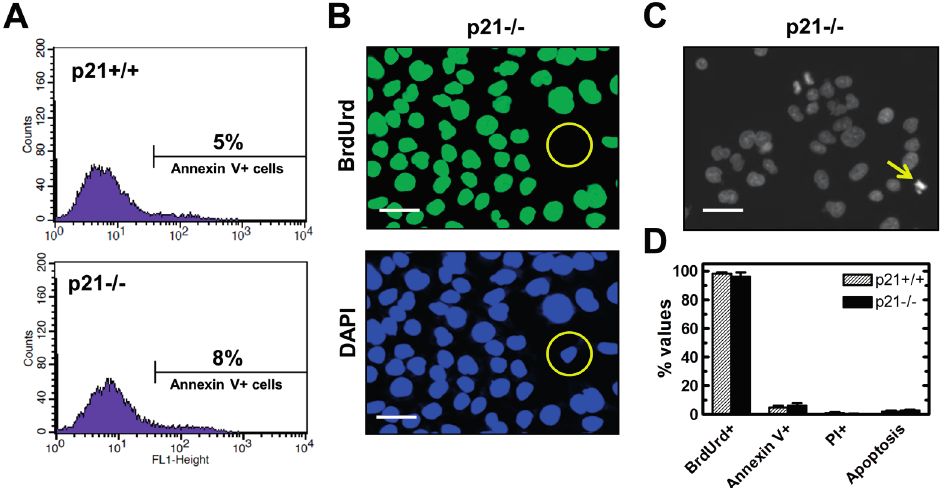
Figure 4. Comparison of HCT116p21+/+ and HCT116p21 − / − cultures for apoptosis, viability and proliferation. ( A ) Flow cytometric evaluation of Annexin V-positive (apoptotic) cells; ( B ) Evaluation of replicating cells by the BrdUrd immunofluorescence assay. Circles mark a cell that did not exhibit DNA synthesis during the 24-h incubation period with BrdUrd; Scale bar, 20 µm; ( C ) Representative image of Hoechst 33258-stained HCT116p21 − / − cells. The arrow marks a cell with apoptotic morphology; Scale bar, 20 µm; ( D ) Comparison of these cultures for the indicated parameters. Bars, SE. PI, propidium